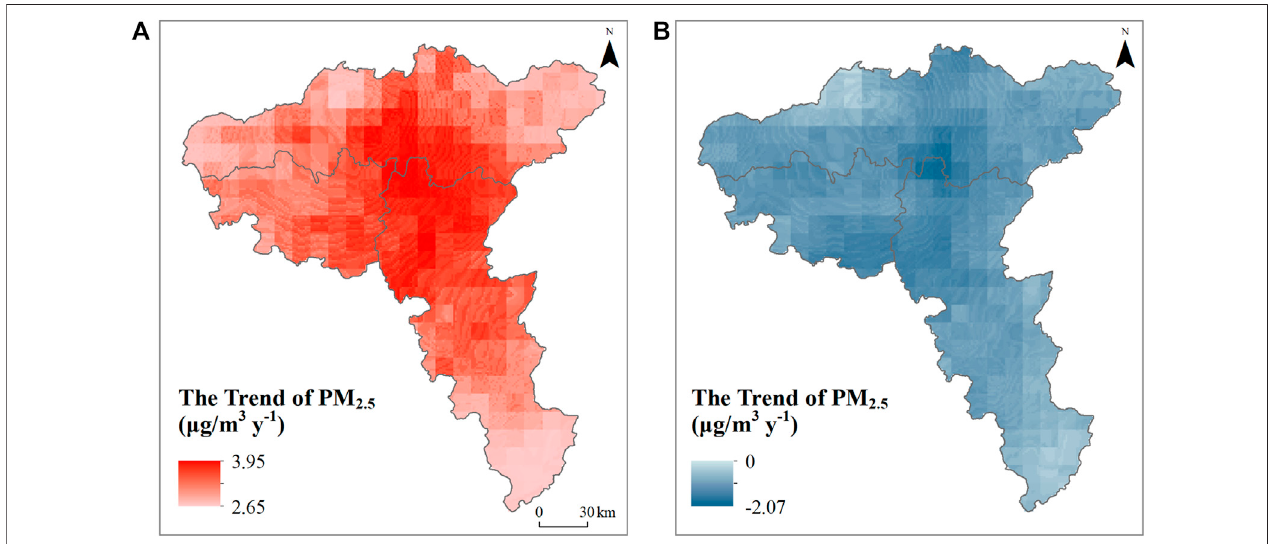
FIGURE 6 | Spatial distribution of the PM 2.5 concentration trends during (A) 2001 – 2008 and (B) 2008 – 2014.